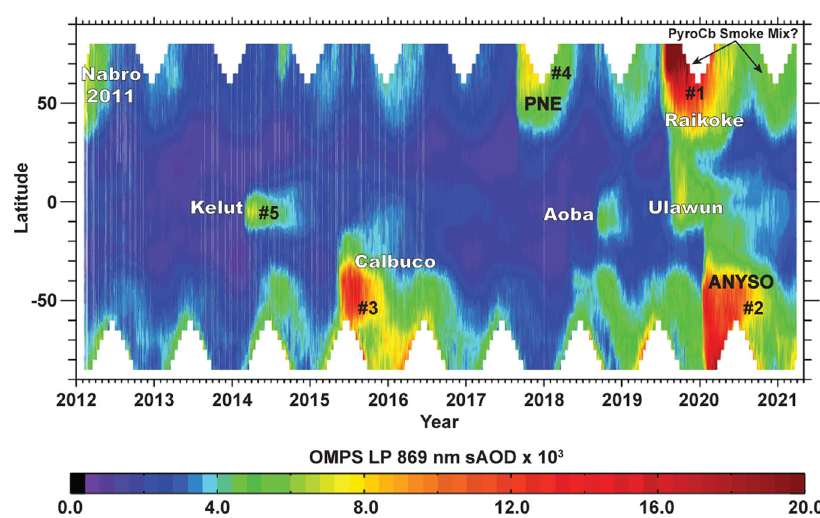
Fig. 10 Comparing ANYSO with all signi fi cant stratospheric plumes observed during 2012 – 2021. Shading indicates daily OMPS LP stratospheric aerosol optical depth (sAOD) calculated in fi ve degree latitude bands using extinction pro fi les at 869 nm. White labels indicate volcanic plumes and black labels indicate pyroCb smoke plumes. Numbers rank the fi ve largest plumes in this record based on maximum